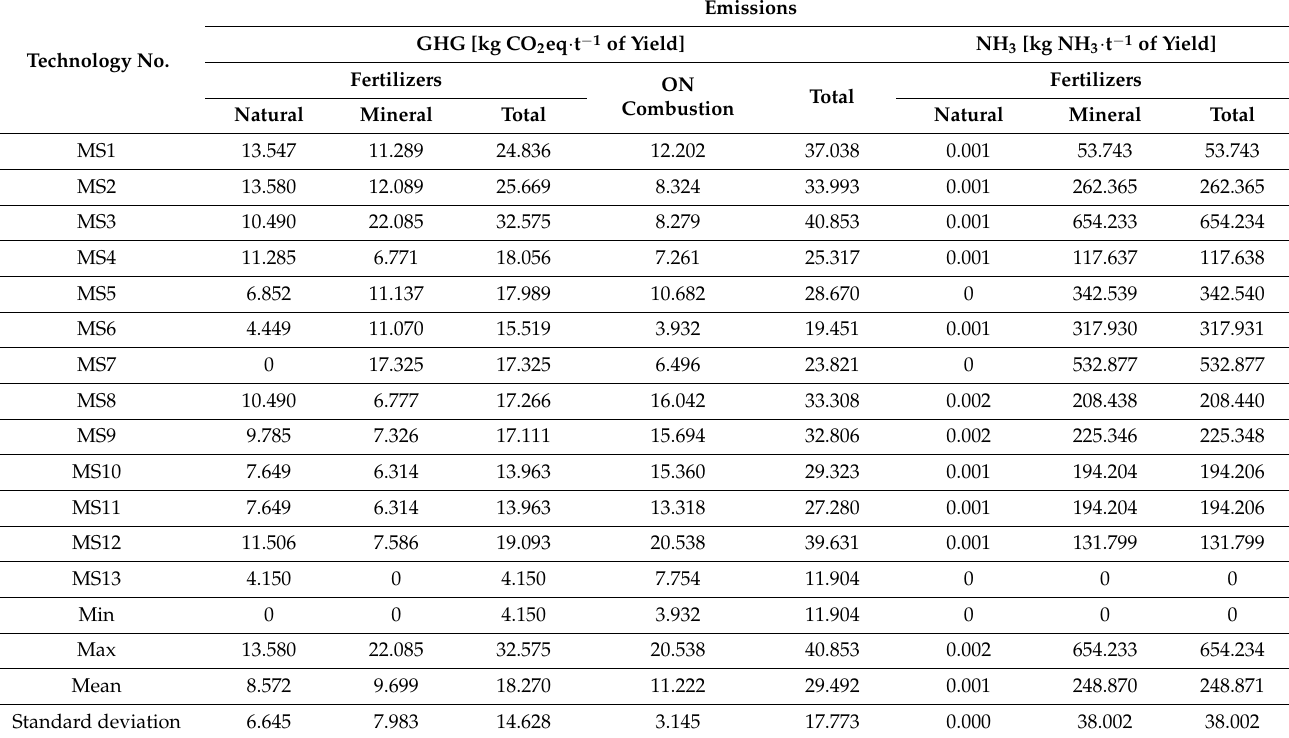
Table 8. GHG and NH3 emissions for respective technologies per yield unit (t).